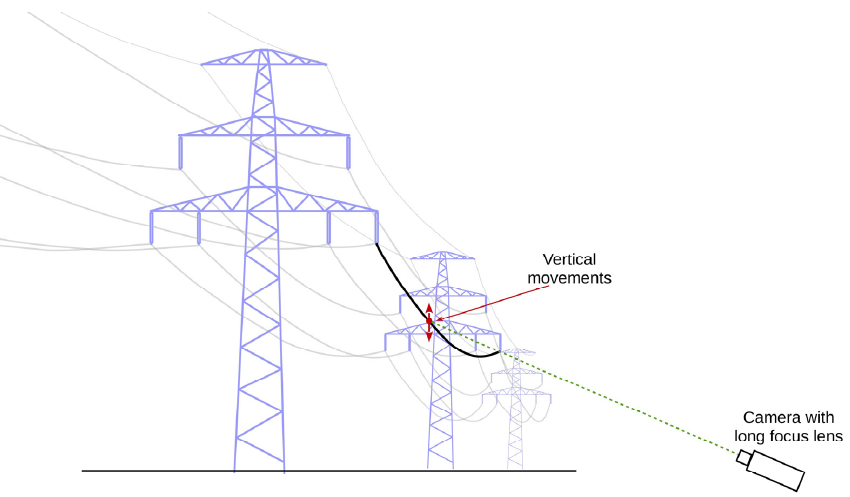
Figure 10. Measurement of the vertical movements of an HV overhead power line conductor—the principle of measurement.